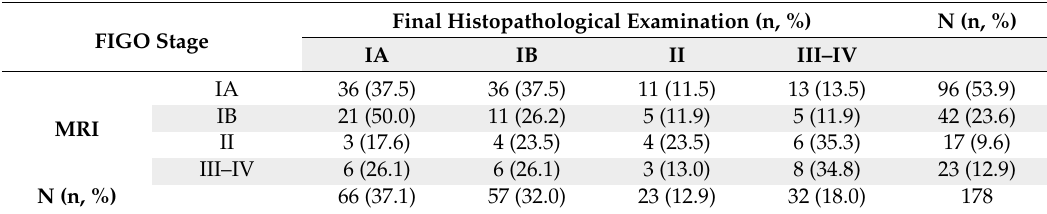
Table 2. Global concordance between MRI and final histopathological examination. Final Histopathological Examination (n, %)